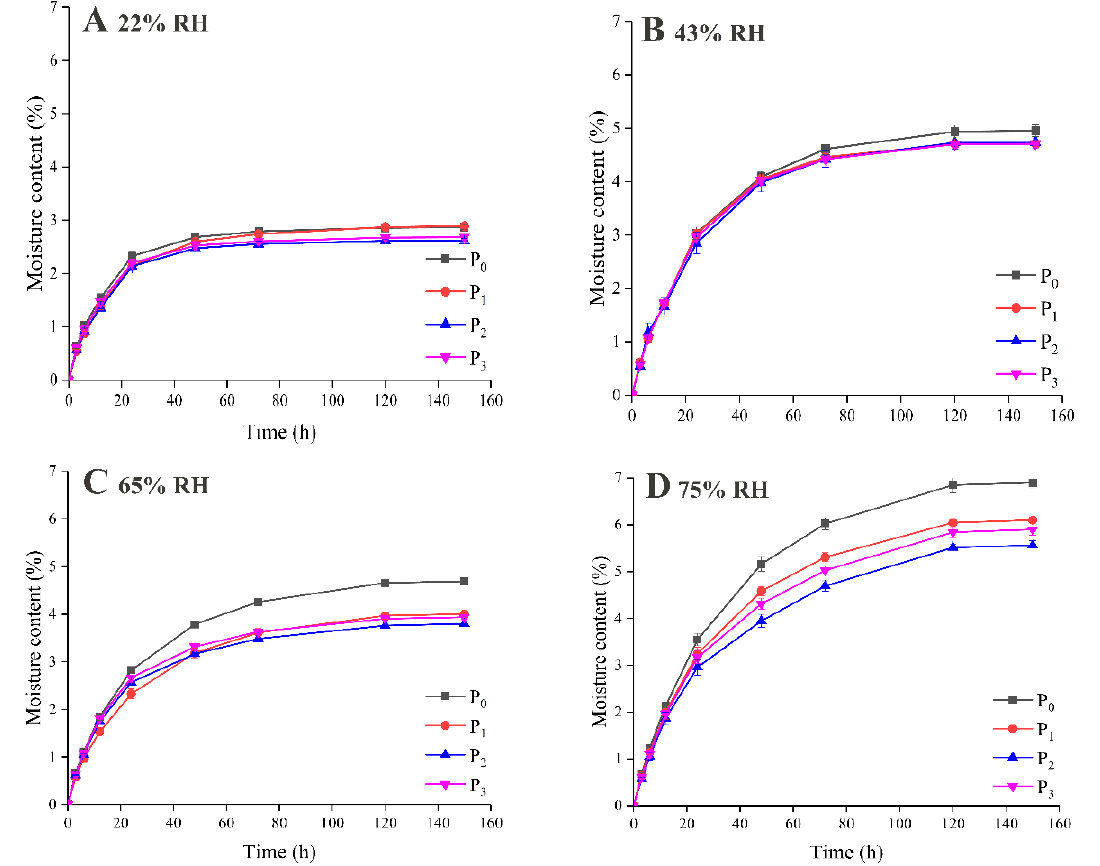
Figure 2. Water adsorption of powdered microcapsules at relative humidity (RH) 22% ( A ), 43% ( B ), 65% ( C ), 75% ( D ) during storage. The wall material was WPI (P 0 ), WPI / MD (DE 6) (P 1 ), WPI / MD (DE 12) (P 2 ), WPI / MD (DE 17) (P 3 ).